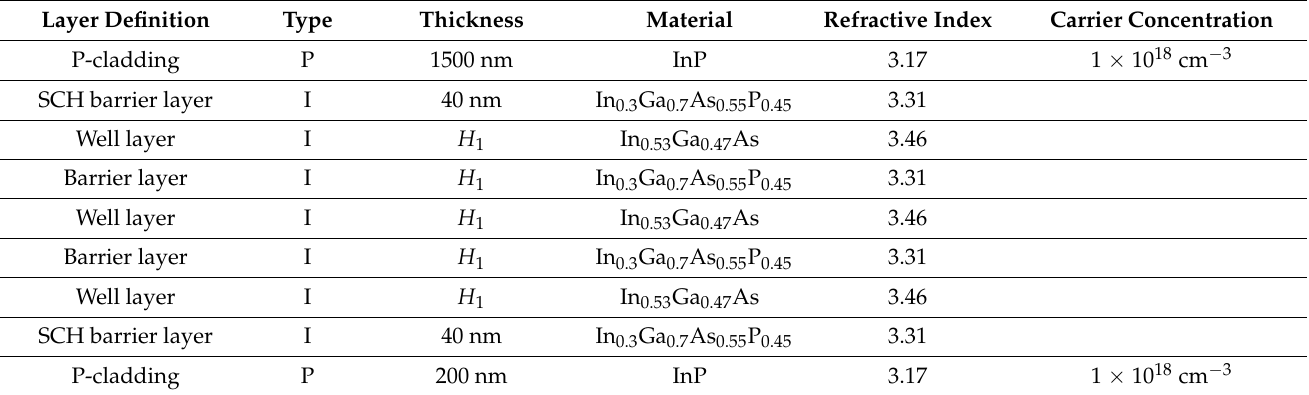
Figure 3. ( a ) The cross-section of the FP quantum well laser. ( b ) I–V curves of the four types of quantum well lasers. ( c ) Effects of temperature on the emission spectra. ( d ) Gain spectra of the four types of quantum well lasers. Table 1. Detailed parameters for each semiconductor layer of the MQW laser. Table 1. Detailed parameters for each semiconductor layer of the MQW laser.